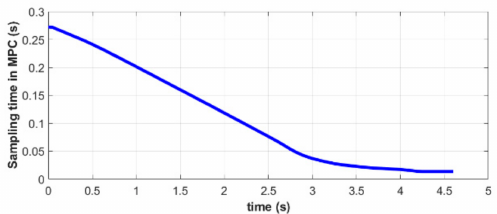
Figure 17. Sampling time of the MPC controller in simulation B.